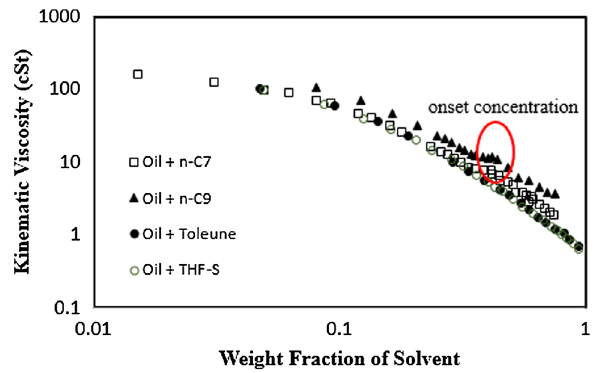
Fig. 5 Kinematic viscosity of Maya crude–solvent mixture versus weight fraction of solvent ( n -C 7 , n -C 9 , Toluene, THF-S) (Escobedo and Mansoori 1995)